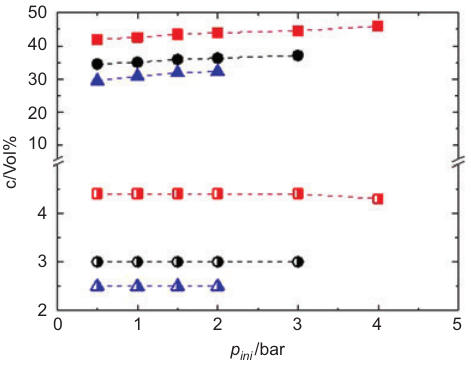
Figure 6 Dependence of detonation limits of hydrocarbon/O mixtures on initial pressure at ambient temperature measured in a 10-mm tube.